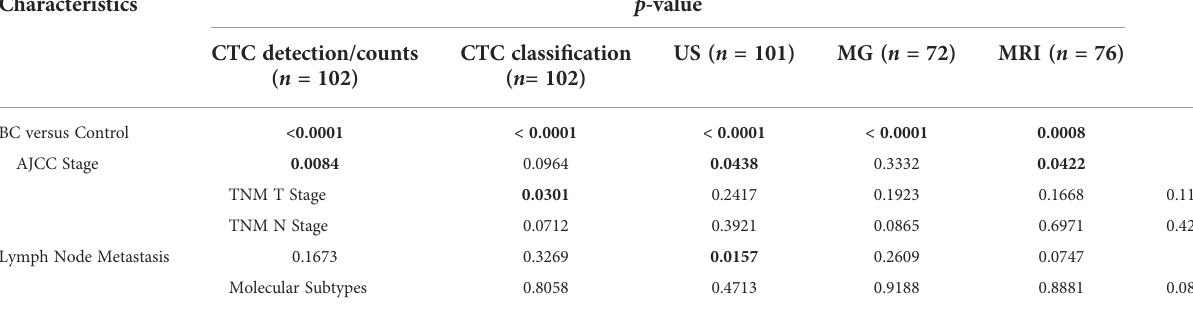
TABLE 2 Correlation of the detection power of CTC tests and imaging modalities and BC clinicopathology * . Characteristics